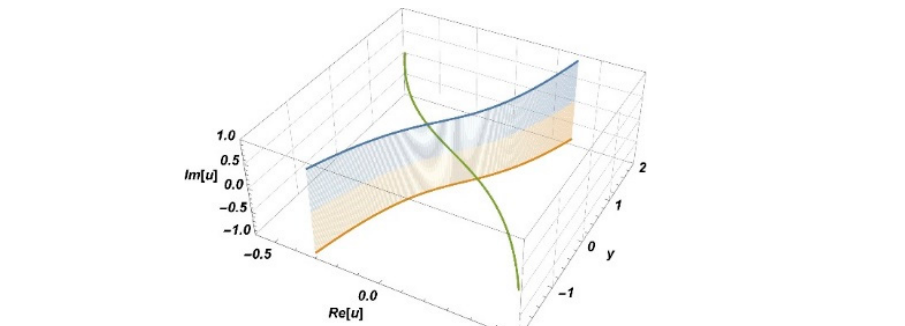
u ) of the function